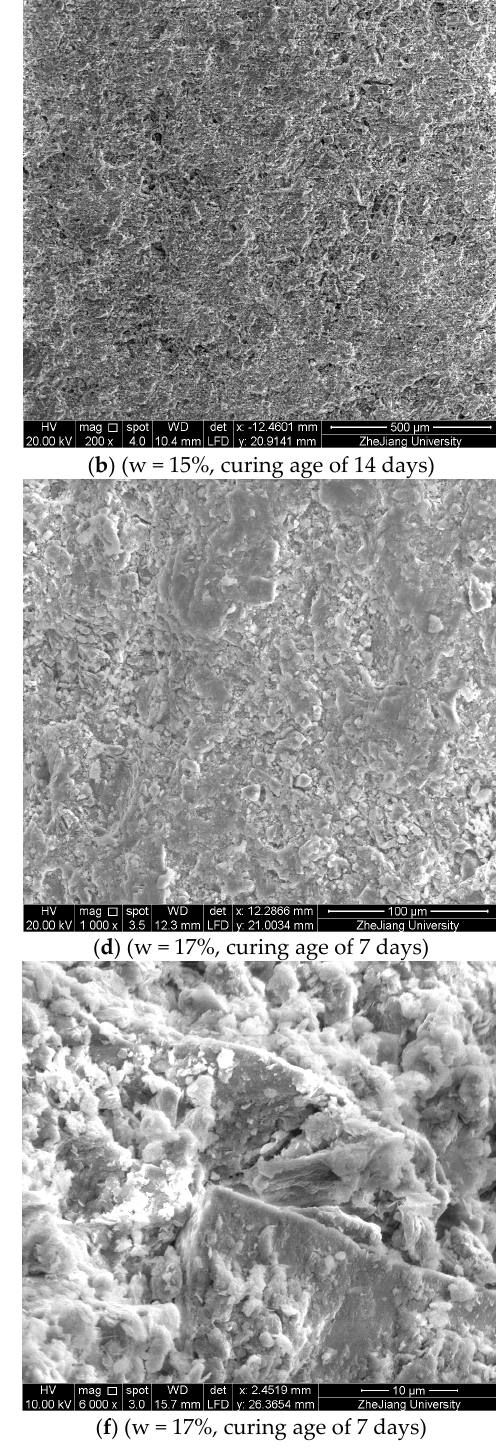
Figure 15. Effects of initial water content on microstructure.